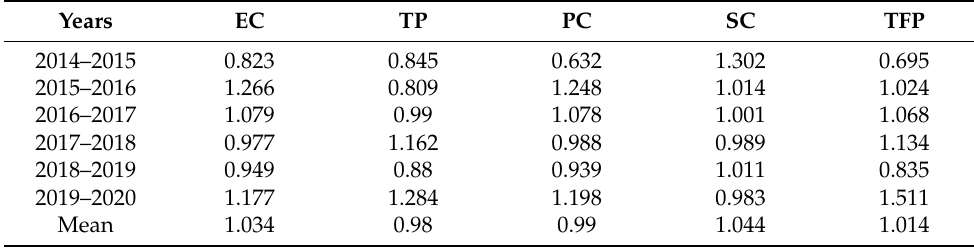
Table 3. Malmquist index dynamic analysis